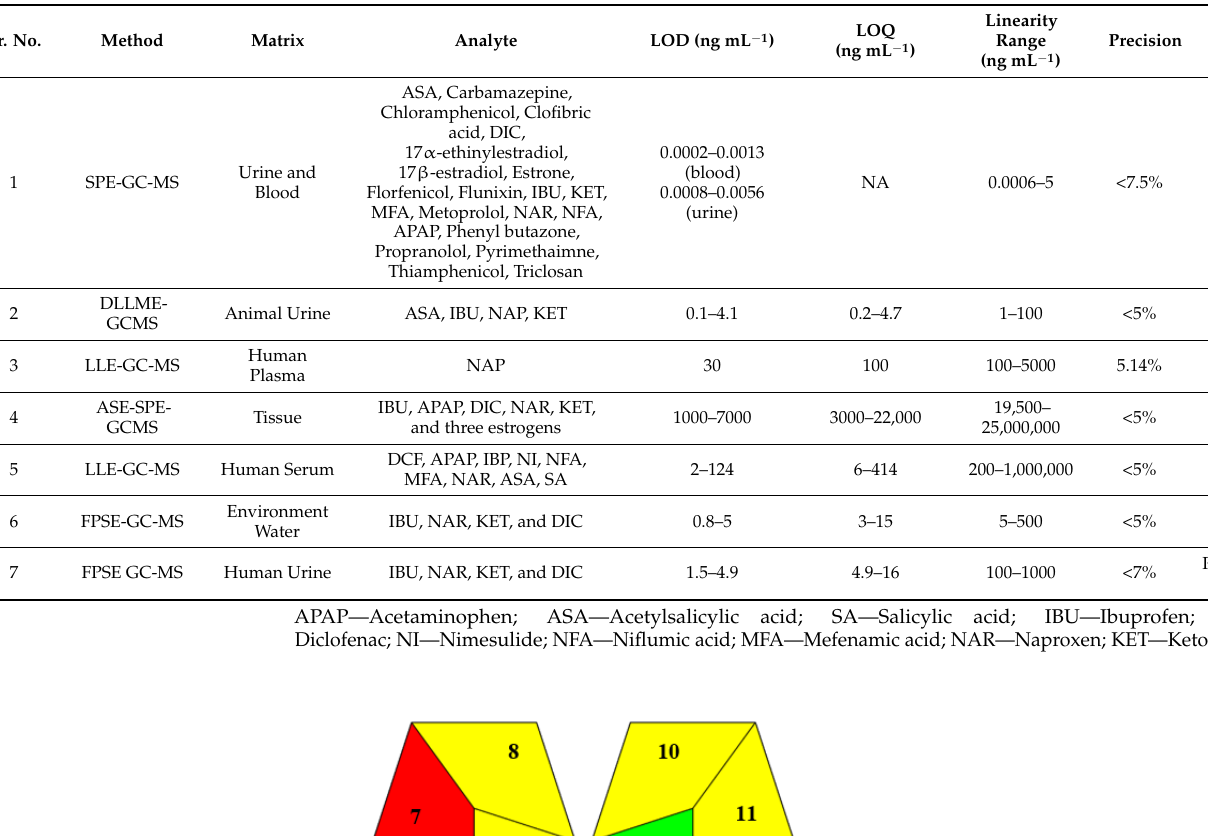
Table 6. Comparison of the proposed method with previously published methods for determining NSAID drugs in different matrices.